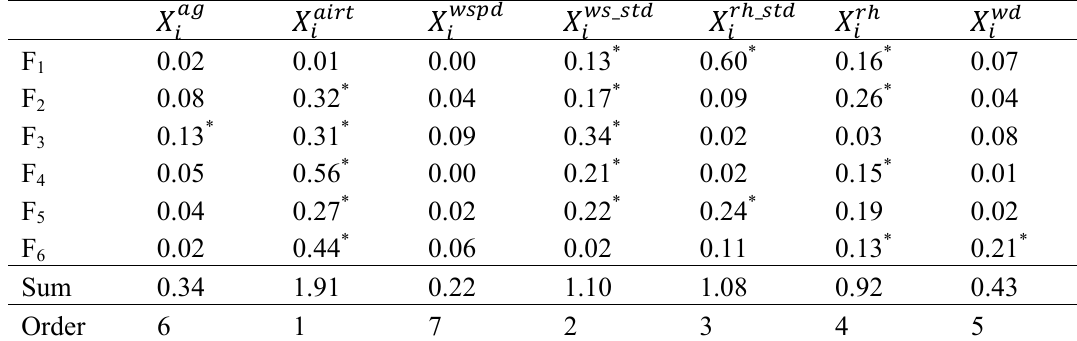
Table 5. BPN weight table of hourly mean